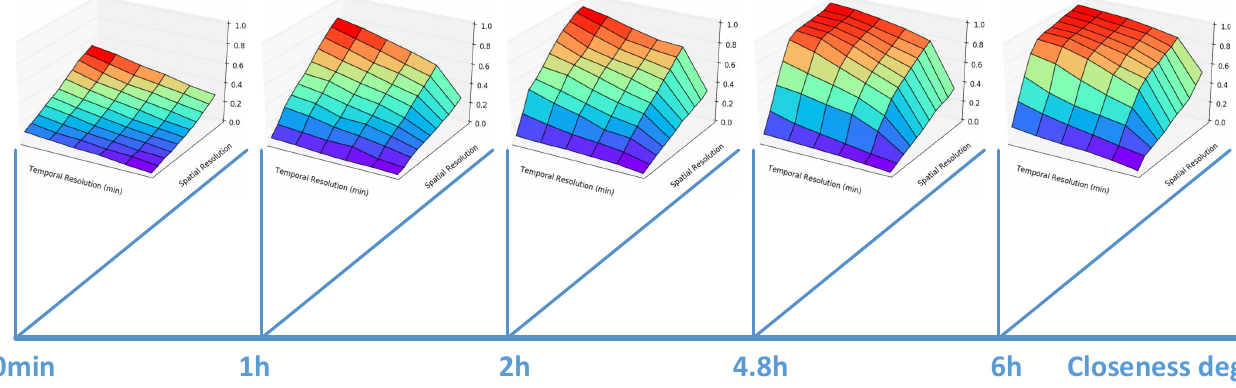
Figure 7. The Uniqueness of Traces with different closeness degree in ShenZhen. Note that the observation points count N takes